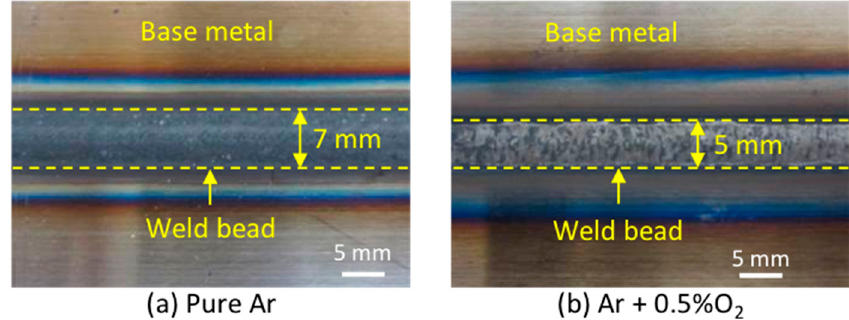
Figure 12. Weld bead width on the top surface of the base metal. ( a ) pure Ar, ( b ) Ar + 0.5% O 2 .